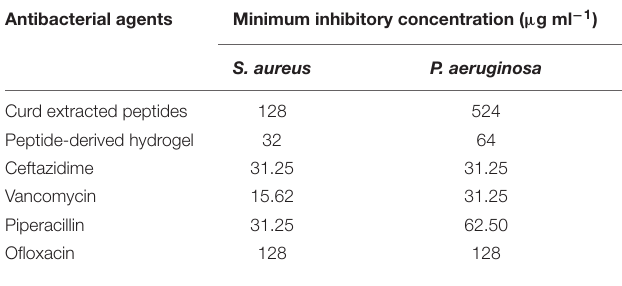
TABLE 1 | Minimum inhibitory concentration (MIC) of peptides, peptide-derived hydrogel, and a few antibiotics. Antibacterial